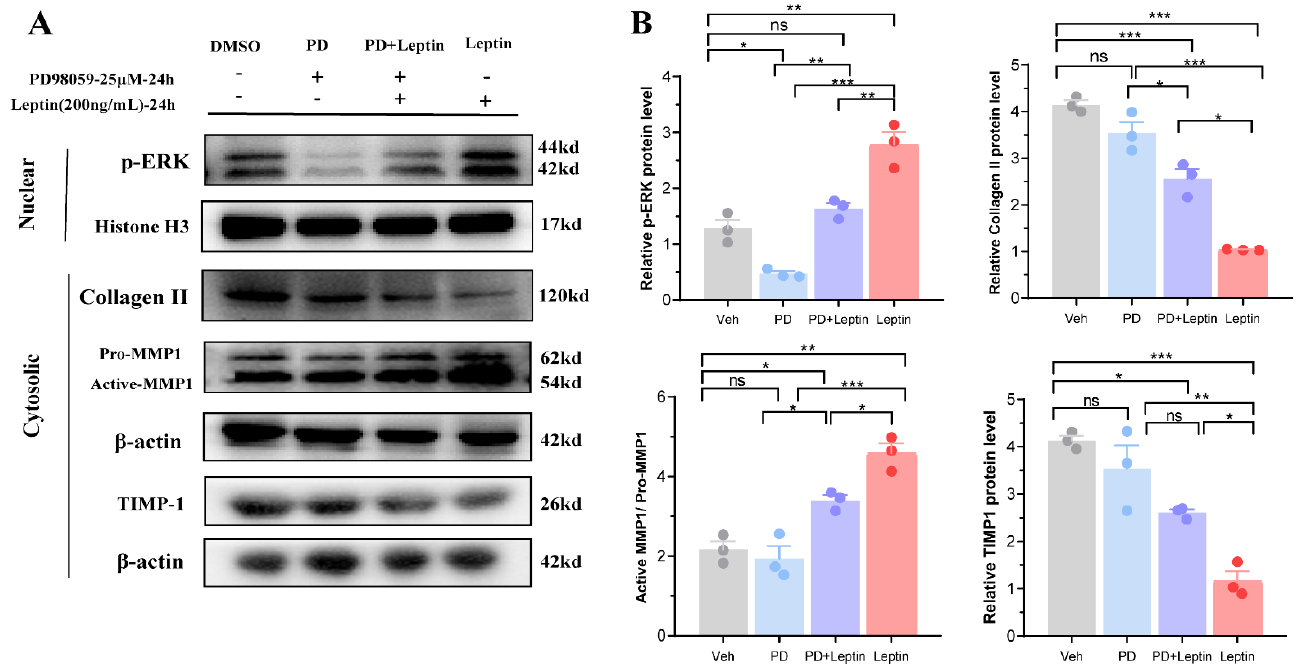
Figure 6. Inhibition of MAPK/ERK signaling pathway altered the expression of collagen II, MMP1, and TIMP1 in vitro. ( A ) Representative western blot bands of the expression of collagen II, MMP1, and TIMP1 in the cell cytoplasm and p-ERK in the nucleus induced by leptin, PD98059 , or dimethyl sulfoxide (DMSO) (carrier for PD98059 ) in vitro ( n = 3, chondrocytes obtained from three separate repeated experiments). ( B ) Statistical analysis of relative protein levels. Results are expressed as mean ± SD. ns not significant, * p < 0.05, ** p < 0.01, and *** p < 0.001.